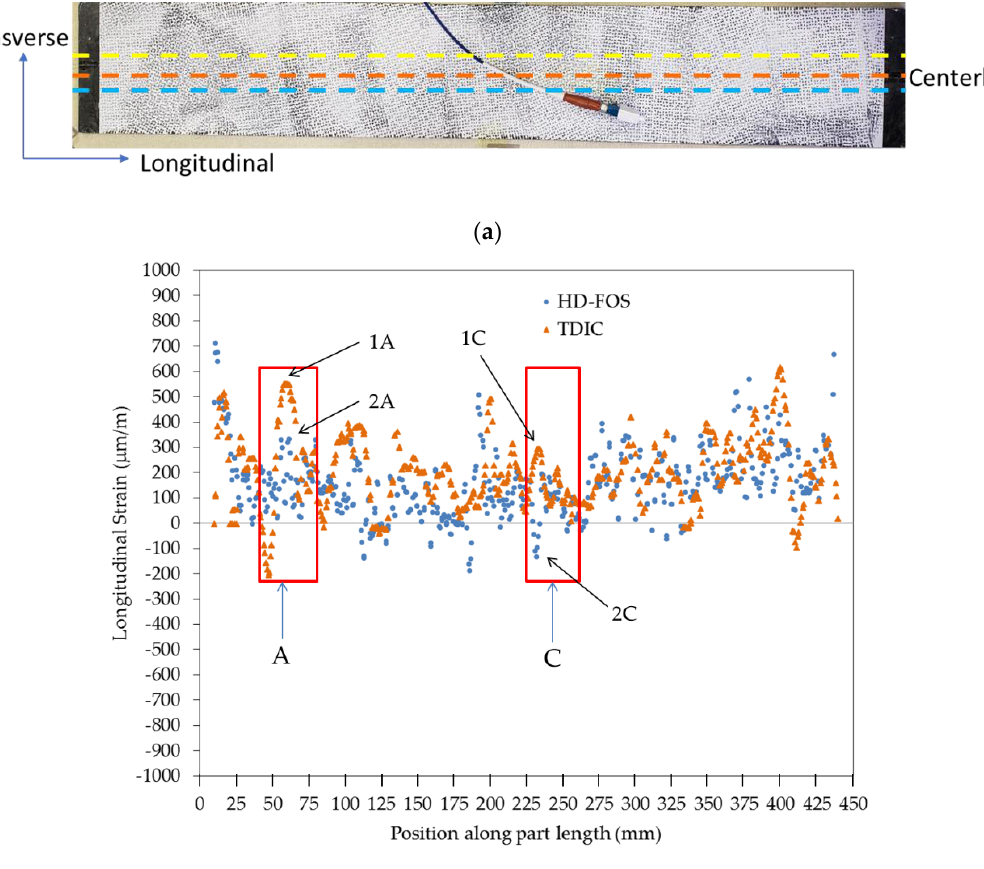
Figure 6. ( a ) Image of the CFSMC panel with fiber-optic sensor (FOS) mounted along the centerline and a speckle pattern on the surface for TDIC measurement. Note the yellow and blue lines are reference lines from TDIC technique used to the compare strain measurements to the HD-FOS strain measurements in the centerline region (orange). ( b ) Comparison of residual strains as a function of location measured by the fiber-optic sensor versus the TDIC technique.